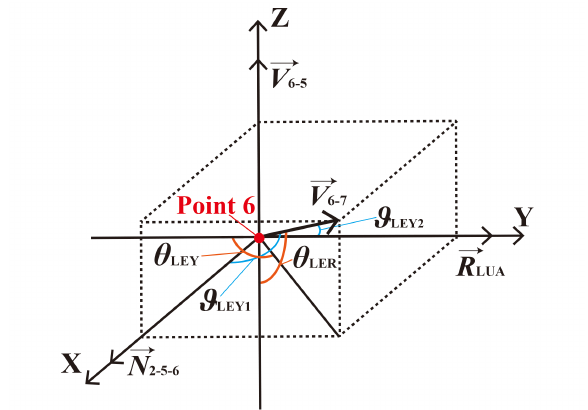
Figure 6. The link frame of the left upper arm of the human skeleton model and the elbow joint angles for mapping.